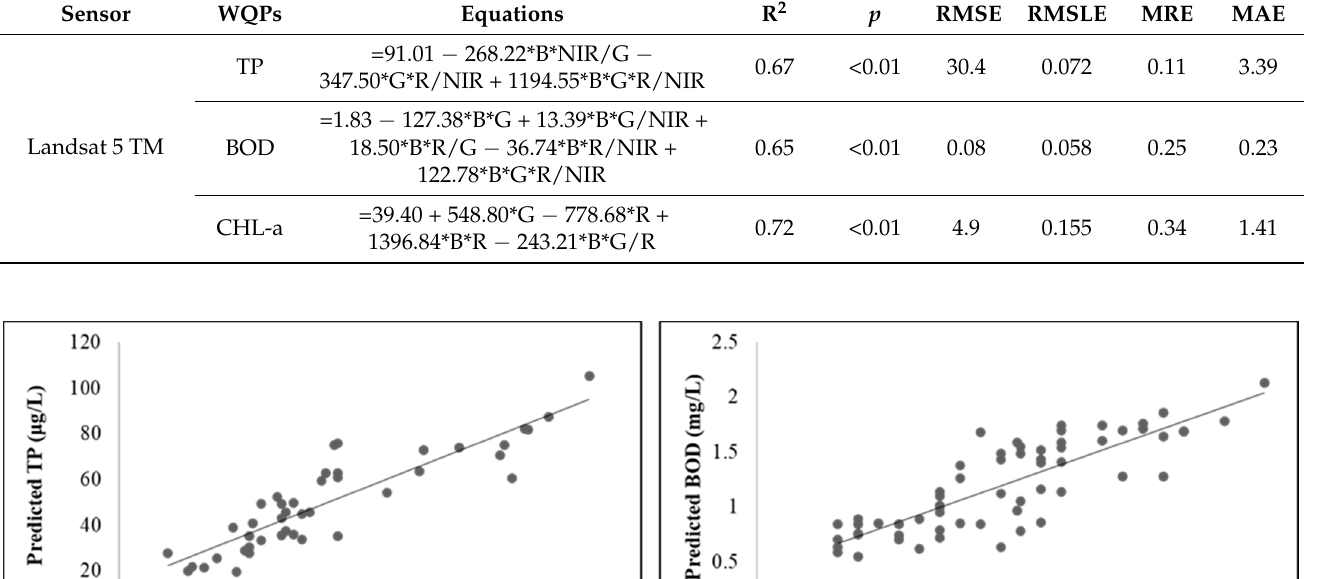
Table 4. Linear equations for Landsat 5 TM to detect TP, BOD and CHL-a of Paldang Reservoir (B: Blue, G: Green, R: Red, NIR: Near-Infrared, TP: Total Phosphorus, BOD: Biological Oxygen Demand, CHL-a: Chlorophyll-a, WQPs: Water Quality Parameters).